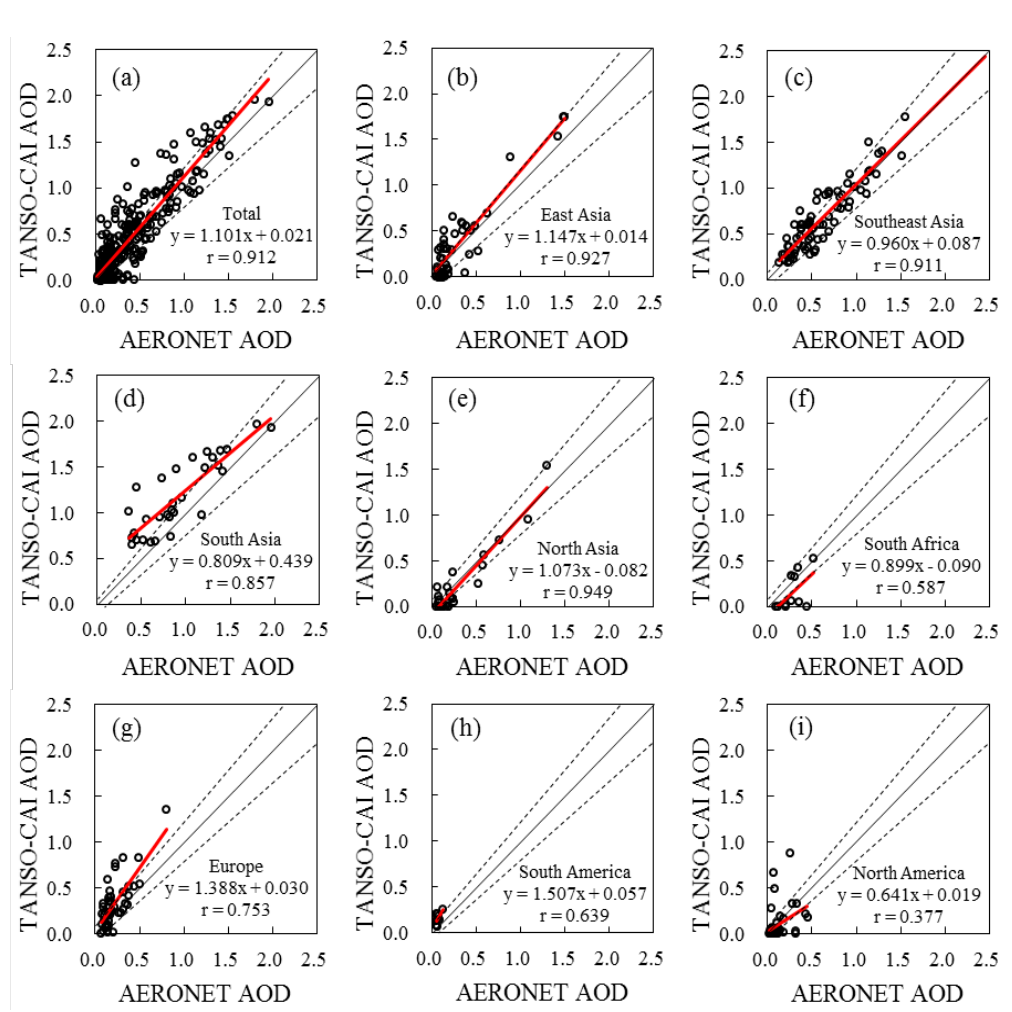
Figure 8. The comparison of retrieved AOD and AERONET measurements over different regions: ( a ) all regions; ( b ) East Asia; ( c ) Southeast Asia; ( d ) South Asia; ( e ) North Asia; ( f ) South Africa; ( g ) Europe; ( h ) South America; and ( i ) North America. The red solid, black solid and dashed lines are the regression line, one-to-one line and expected error (EE1) ( ± 0.05 ± 0.15AOD (AERONET) ) envelope line, respectively.